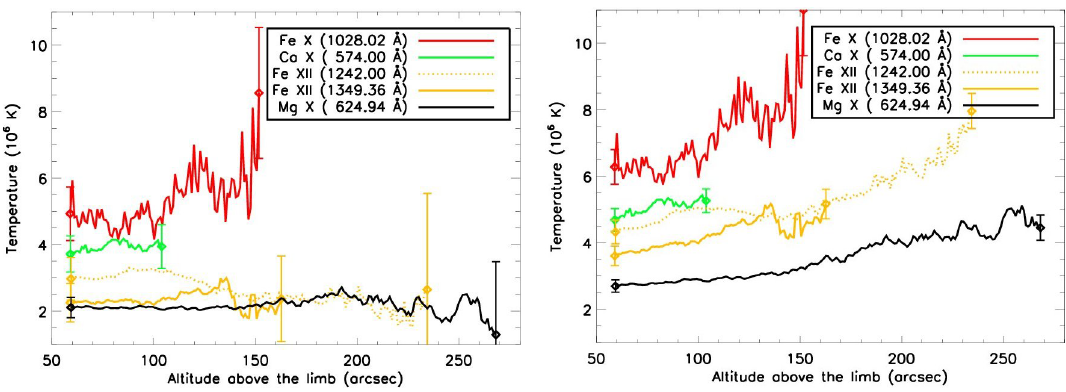
Fig. 4. Temperatures derived from the line widths. Left panel: when the non-thermal velocity is removed. Right panel: when no non-thermal velocity is